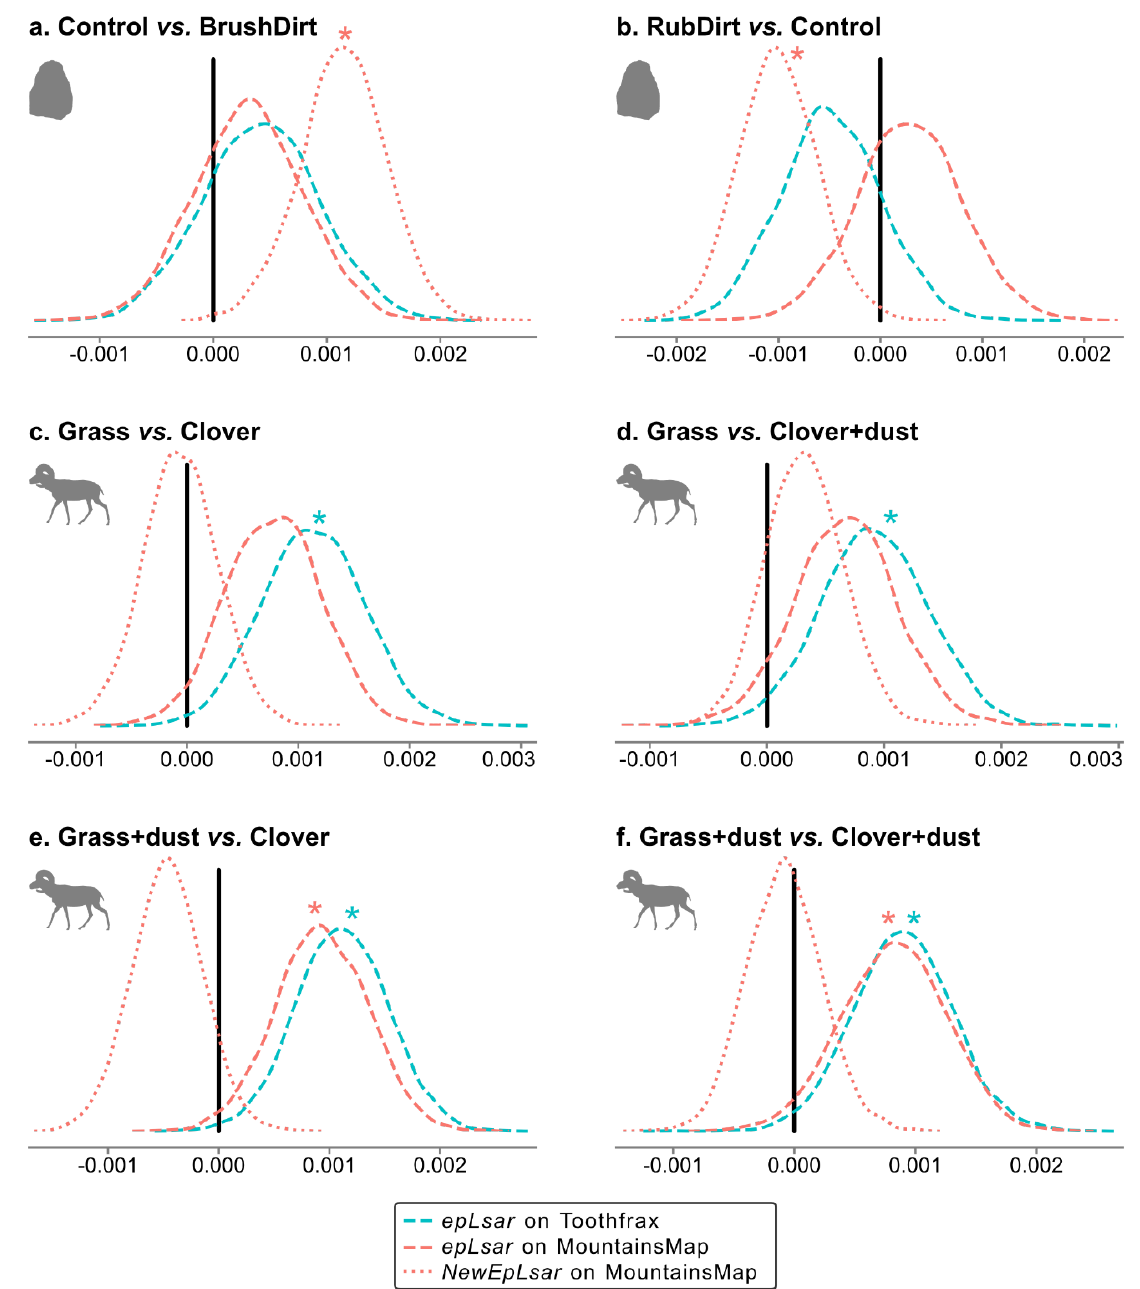
Fig. 6. Contrasts of treatment pairs for which NewEpLsar disagrees with epLsar from at least one software package on the surfaces with < 5% NMP. See Table 3 for 95% HDIs, Fig. 4 for details on how to read the plots and for abbreviations, Figs 1&3 for details on silhouette, and text for details on surface parameters and